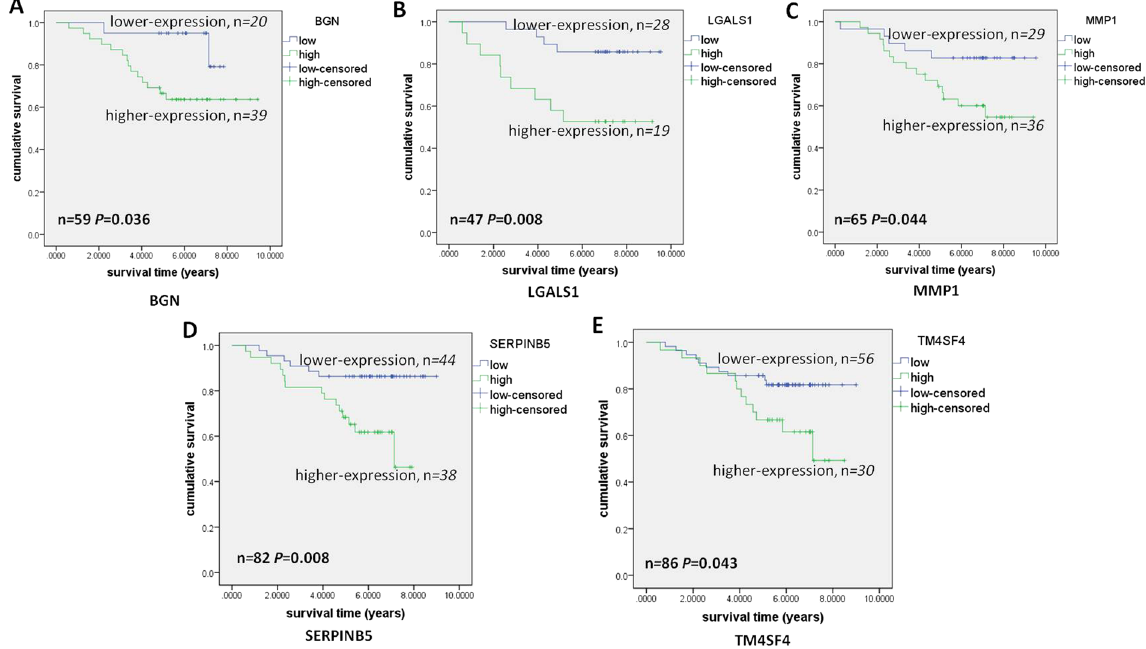
Figure 8. Kaplan-Meier analysis. ( A ) Survival analysis for the CRC patient specimens (n = 59). The patients with higher expression of BGN had poorer survival than those with lower expression of BGN ( P = 0.036). ( B ) Survival analysis for the CRC patient specimens (n = 47). Kaplan-Meier univariate analysis demonstrated a significantly decreased survival probability in patients with higher LGALS1 levels ( P = 0.008). ( C ) Survival analysis for the CRC patient specimens (n = 65). Kaplan-Meier analysis demonstrated that patients with higher MMP1 expression in CRC had poorer survival than those with low MMP1 expression ( P = 0.044). ( D ) Survival analysis for the CRC patient specimens (n = 82). The patients with high SERPINB5 expression showed a decreased in survival probability compared with those with low SERPINB5 expression ( P = 0.008). ( E ), Survival analysis for the CRC patient specimens (n = 86). Kaplan-Meier analysis demonstrated a significantly decreased survival probability in patients with higher TM4SF4 levels ( P = 0.043, log-rank